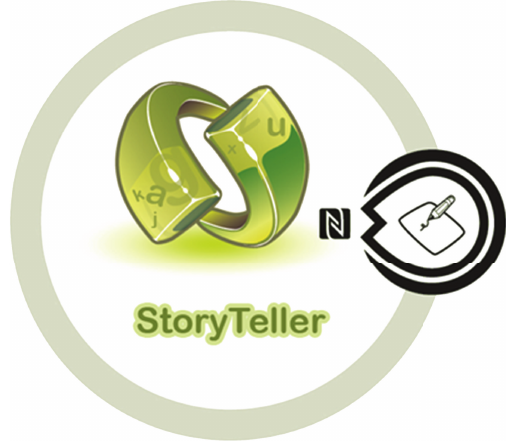
Figure 14: A service advertisement for creating a prefilled StoryTeller message.